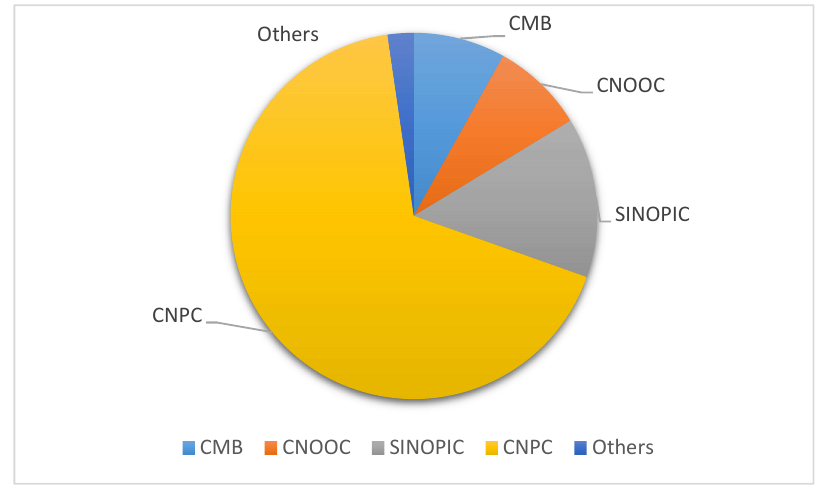
Figure 13. China’s domestic natural gas suppliers in 2013.